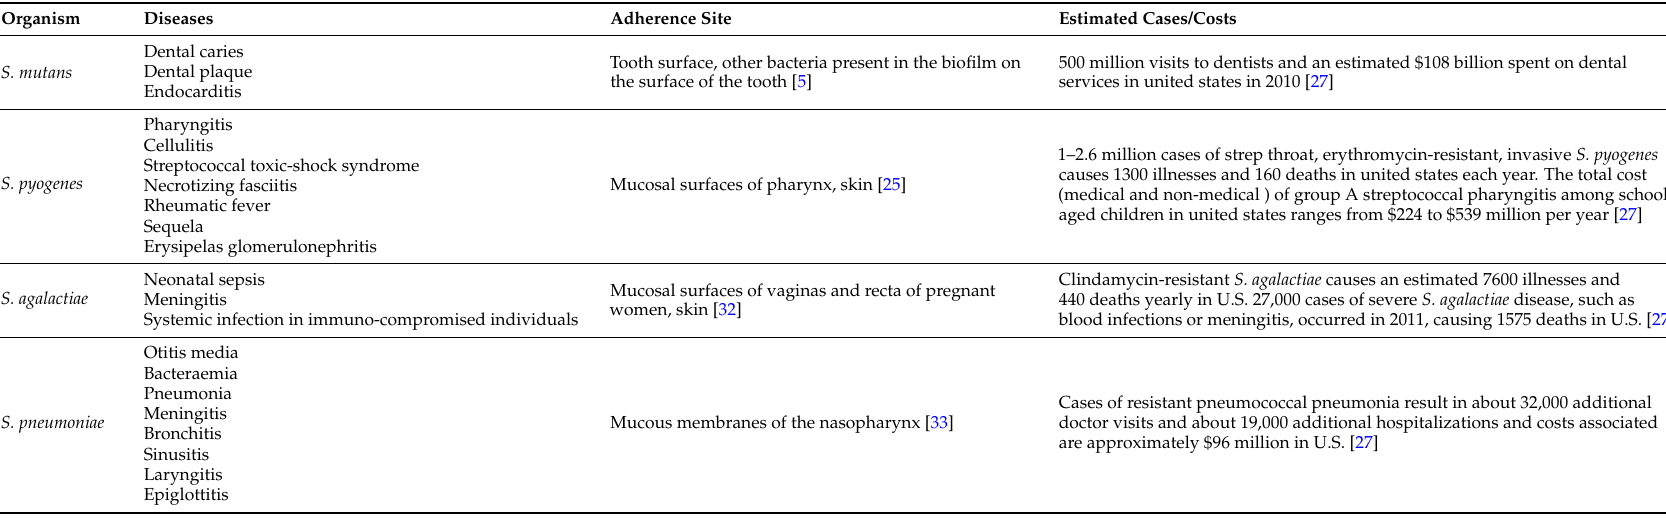
Table 1. Demonstrated virulence factors of streptococci species, disease caused and the associated social and financial cost with the disease.